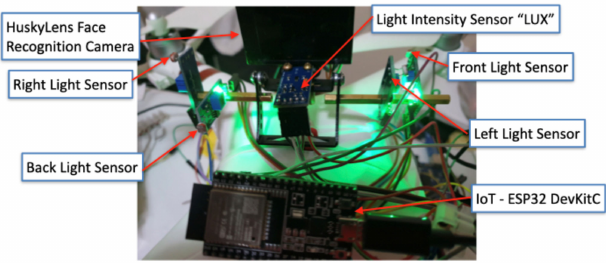
Figure 7. Guidance Landing System (GLS) hardware